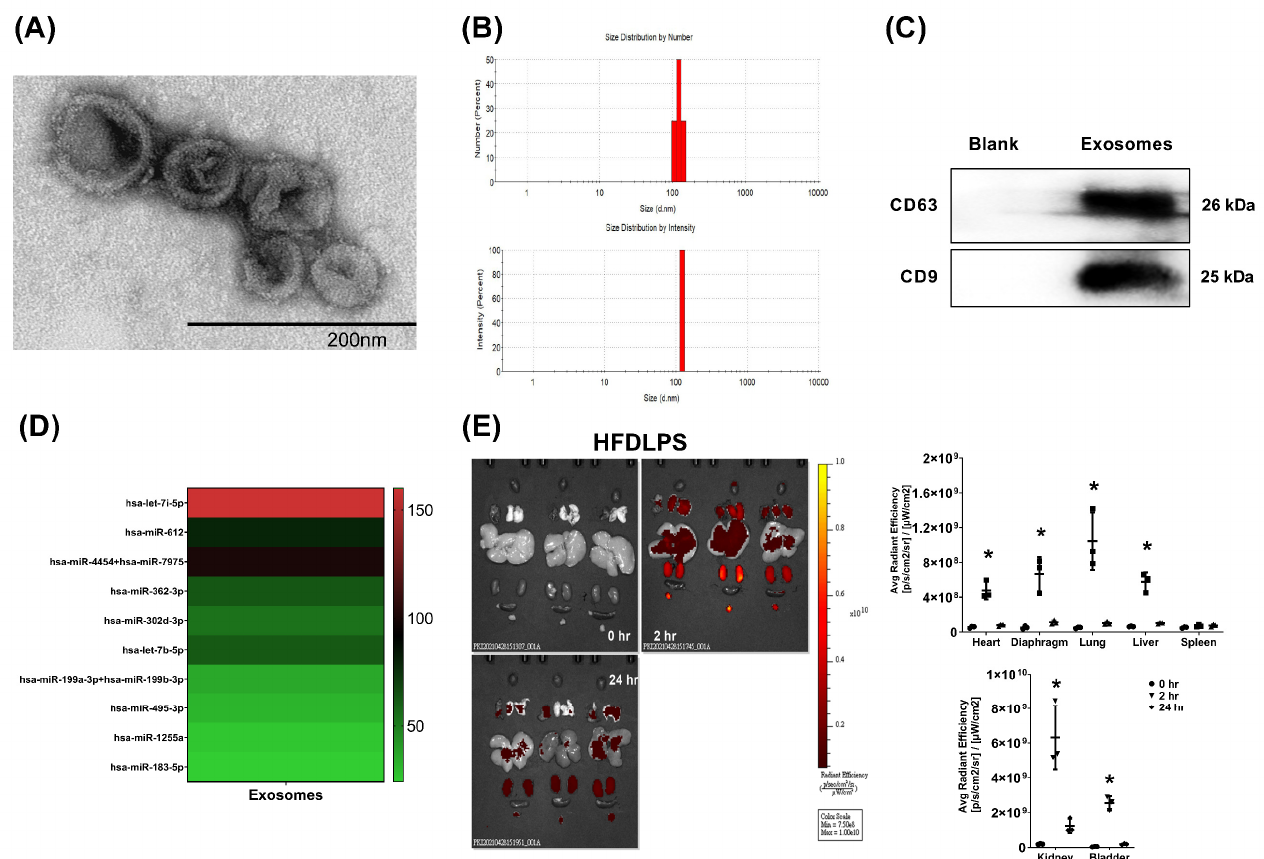
Figure 1. ( A ) Representative transmission electron microscopic images (60,000 × ) of exosomes (from human placenta choriodecidual membrane-derived mesenchymal stem cells, pcMSCs). ( B ) Particle and sizing analysis of exosomes. ( C ) Representative gel photography of exosome markers CD63 and CD9, detected using an immunoblotting assay. ( D ) The heatmap illustrating the top 10 most abundant microRNAs identified in exosomes. ( E ) Biodistribution of exosomes (conjugated with Cy7 mono NHS ester, 1 × 10 8 particles per mouse) in endotoxin-treated high-fat diet obese (HFDLPS) mice measured at 0, 2, and 24 h after intraperitoneal administration, determined using an ex vivo bioluminescence imaging assay. Biodistribution data were derived from 3 mice at each time point and presented as the mean ± standard deviation. * p < 0.05, versus the signal intensity measured at 0 h.